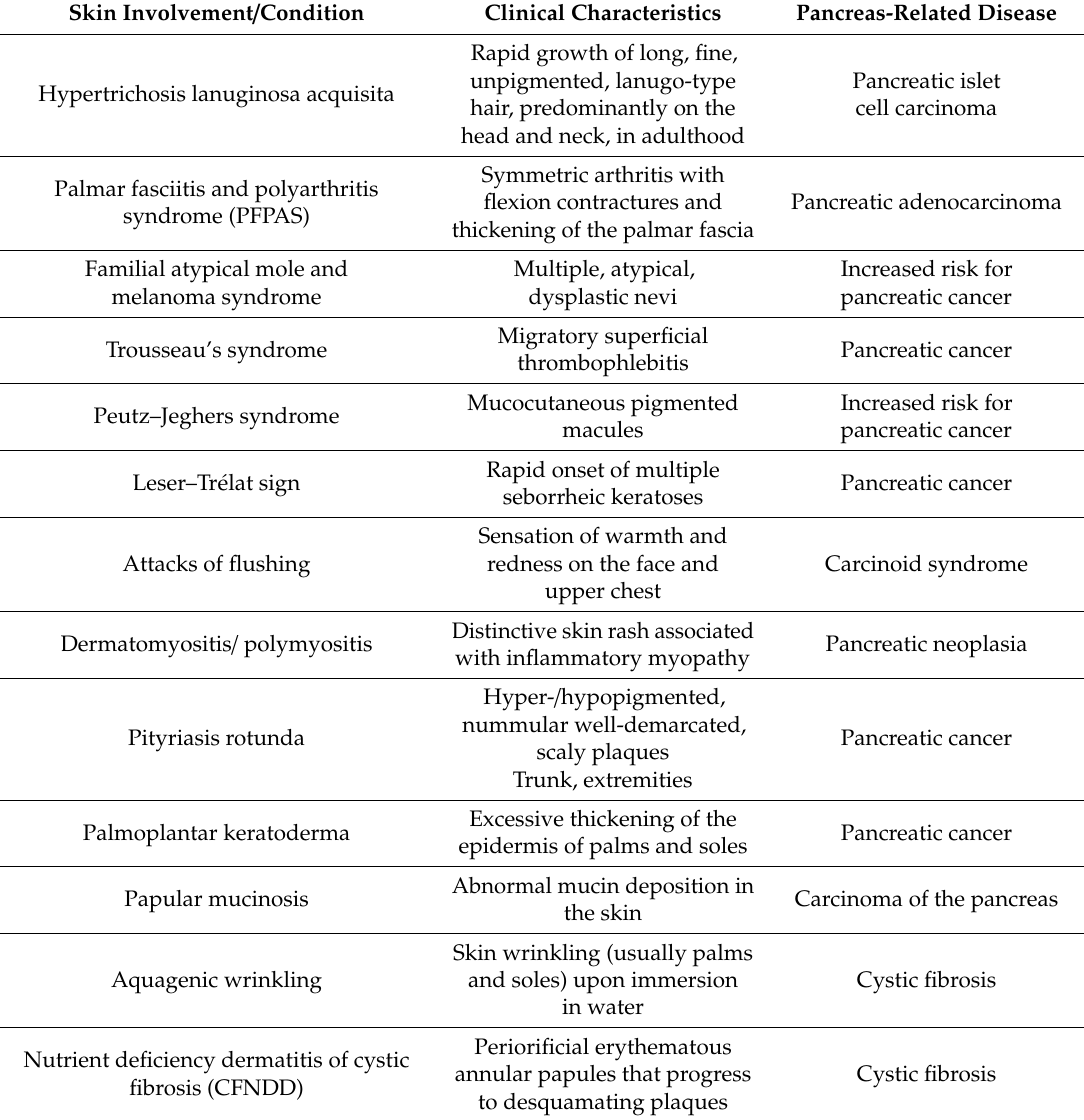
Table 2. Other cutaneous signs associated with pancreatic